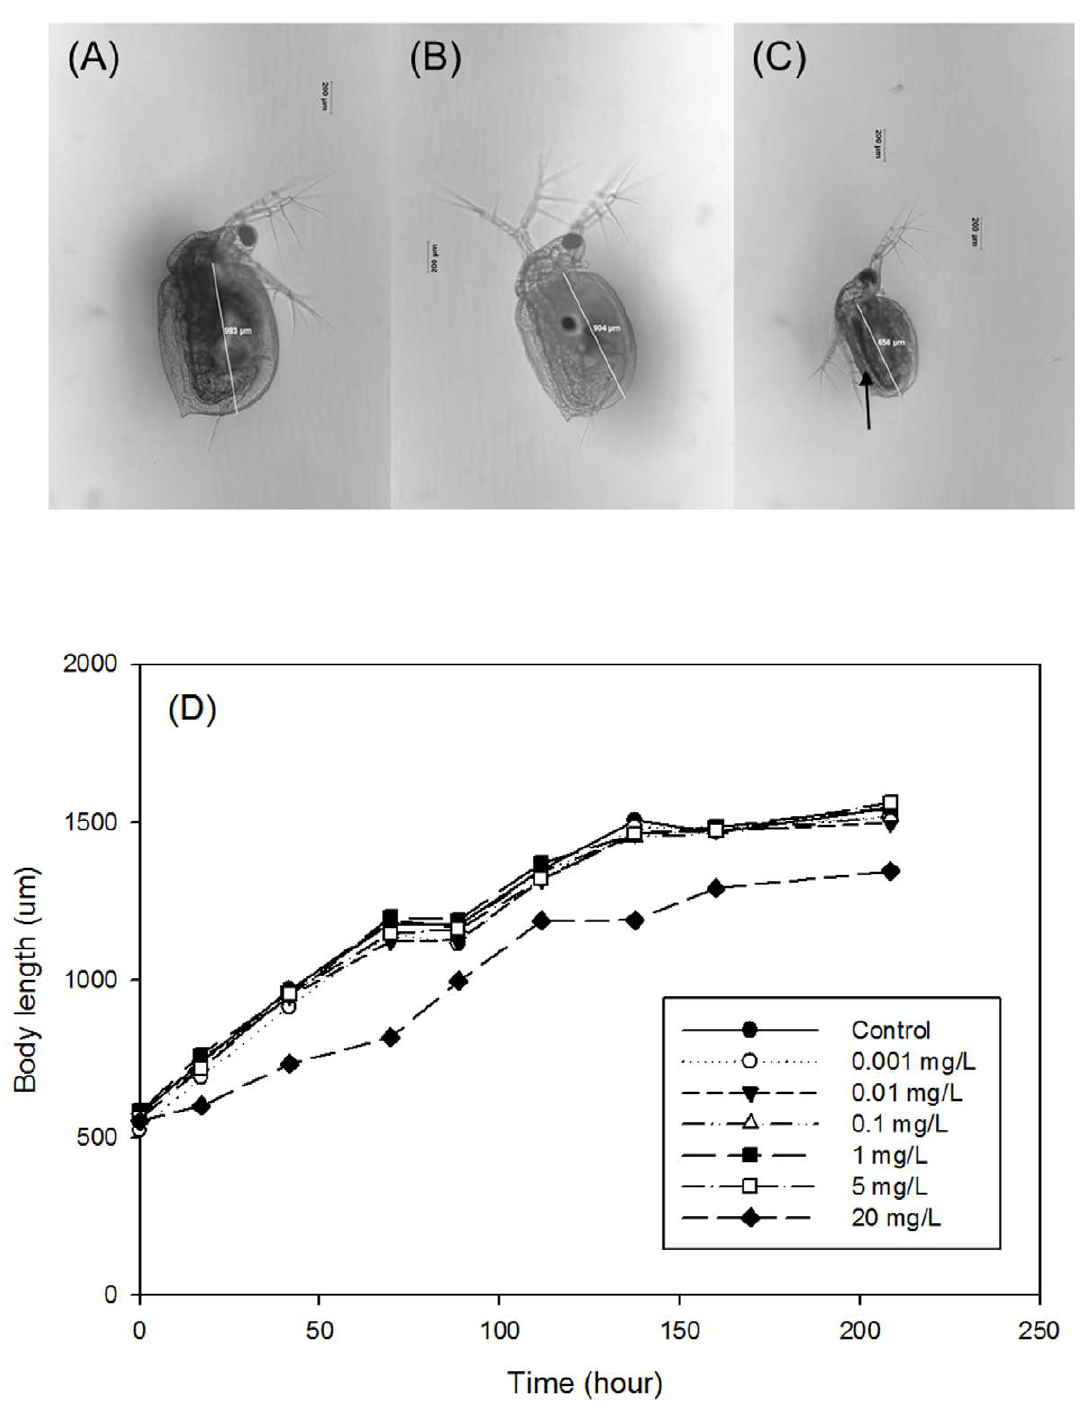
Figure 6. Microscopic images (10X magnification) of daphnids exposed to control and pH treatments after 2 days. (A) Control, (B) treatment with 0.001 mg/L of PHF, and (C) treatment with 20 mg/L of PHF. (D) Mean body length of daphnids over a duration of 8 days in response to various concentrations of PHF (n=2).